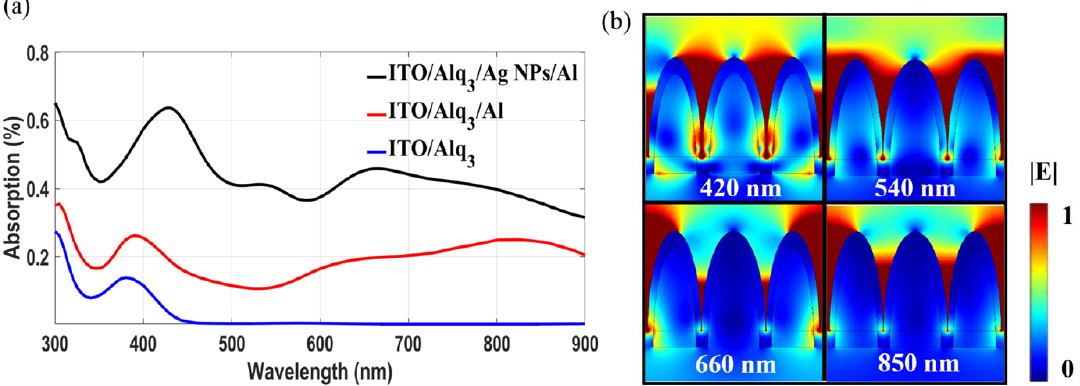
Figure 4. ( a ) Calculated absorption spectra of the ITO/Alq 3 film, the control OPD (ITO/Alq 3 /Al), and the plasmonic OPD (ITO/Alq 3 /AgNP/Al). ( b ) Maps of |E| for plasmonic OPD at the wavelengths of 420 nm, 540 nm, 660 nm, and 850 nm.